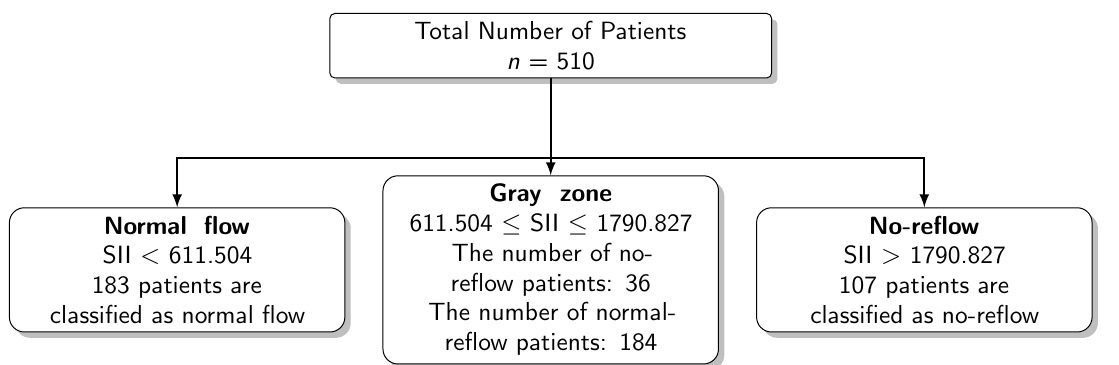
Figure 3. Scheme of the Uncertain Interval Approach.